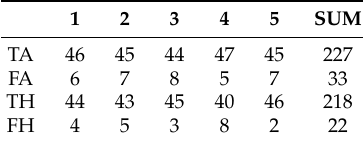
Figure 12. Output values of five test experiments. Table 6. Results of five test experiments.